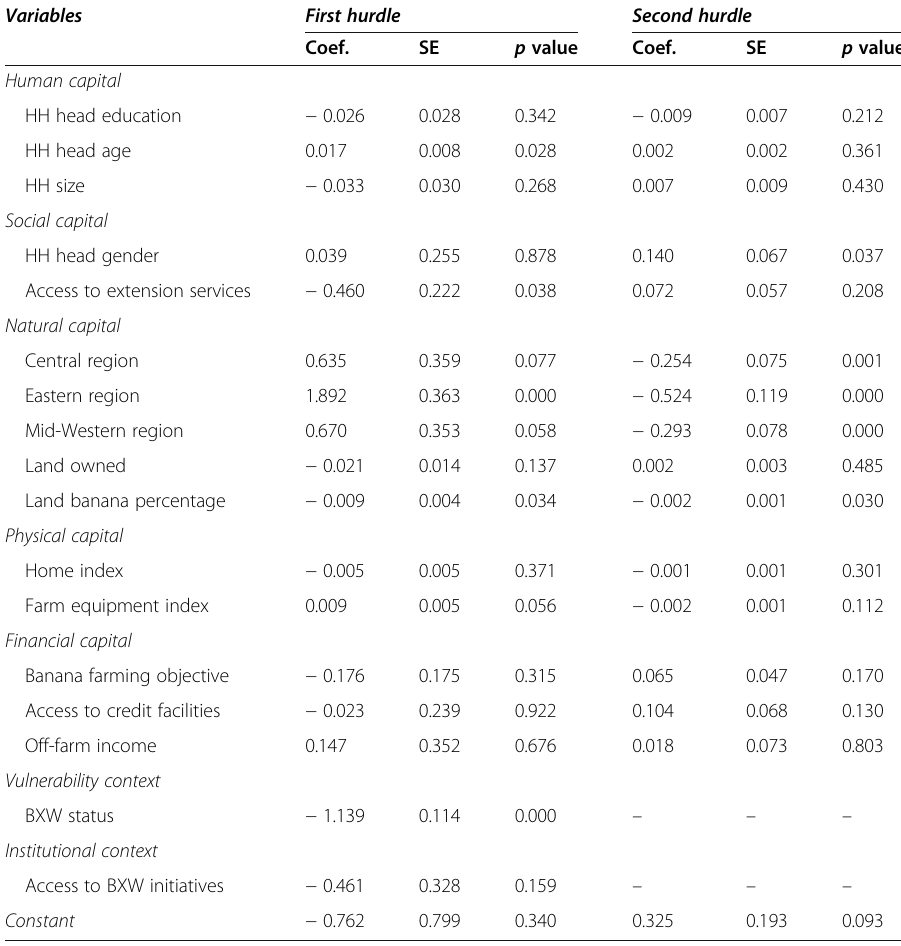
Table 4 Results of the Poisson-logit hurdle model Variables First hurdle